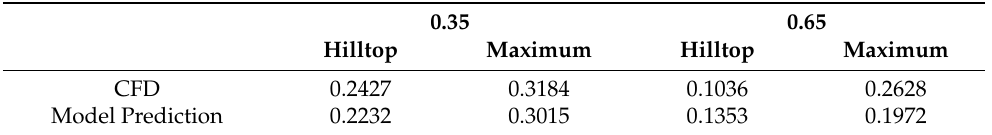
Table 4. Speedup ratio of different